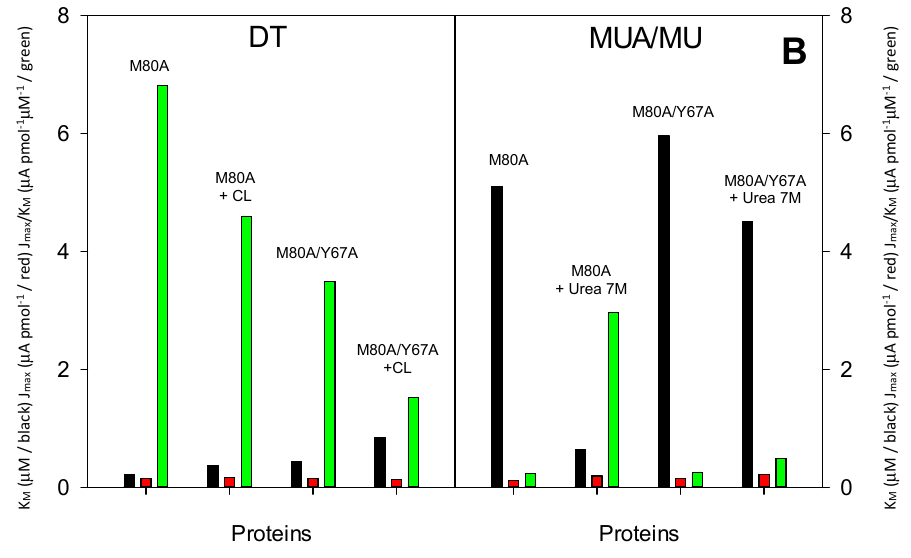
Figure 6. Histograms depicting the K M ( µ M, black bar), J max ( µ A pmol − 1 , red bar) and J max / K M × 10 ( µ A pmol − 1 µ M − 1 , green bar) values for the reductive electrocatalysis of ( A ) H 2 O 2 and ( B ) NO 2 − , carried out by wt yeast iso-1 cytochrome c and its M80A and M80A/Y67A variants immobilized on a gold electrode functionalized with a hydrophobic SAM of decane-1-thiol (DT) and a negatively charged SAM of MUA/MU, along with the corresponding adducts with cardiolipin (this work) and the same species in 7M urea immobilized under the same conditions. Figure ( A left frame): 1, wt; 2, wt + CL, 3, M80A; 4, M80A + CL; 5, M80A/Y67A; 6, M80A/Y67A + CL. Figure ( A right frame): 1, wt; 2, wt + Urea 7M, 3, M80A; 4, M80A + Urea 7M; 5, M80A/Y67A; 6, M80A/Y67A + Urea 7M. Figure ( B left frame): 1, M80A; 2, M80A + CL; 3, M80A/Y67A; 4, M80A/Y67A + CL. Figure ( B right frame): 1, M80A; 2, M80A + Urea 7M; 3, M80A/Y67A; 4, M80A/Y67A + Urea 7M. Reprinted with permission from ref. [39]. Copyright 2020